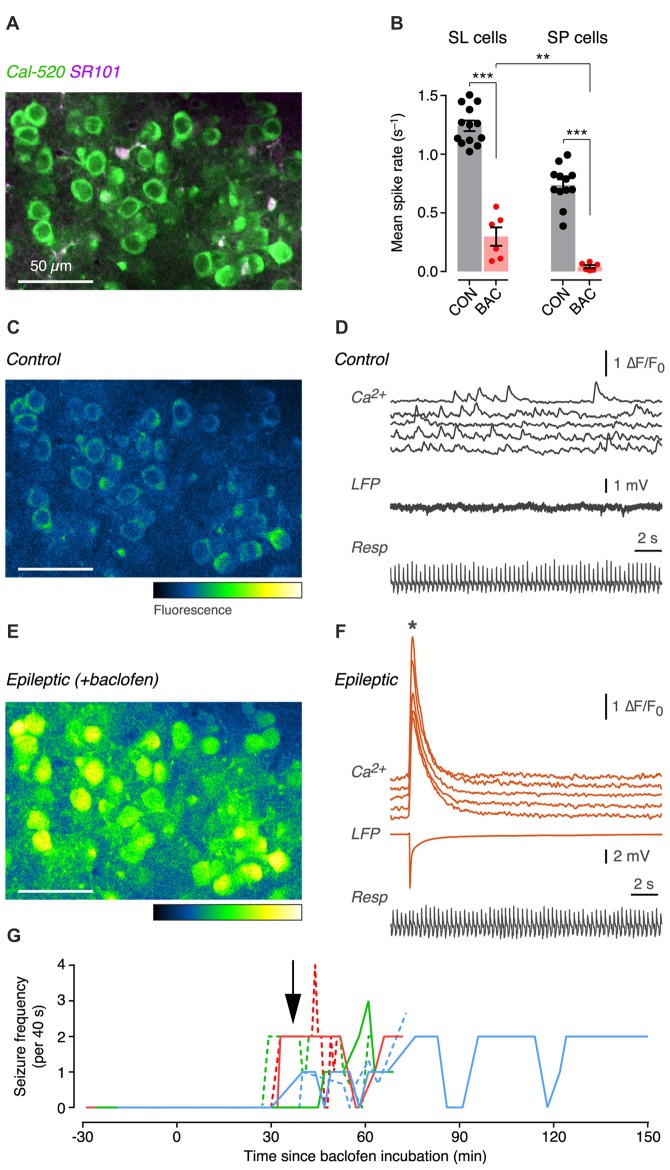
GABAB receptor activation both suppresses and enhances the excitability of SL and SP cells in the PC in vivo. (A) Two-photon composite image of SP cell somas labeled with the calcium indicator, Cal-520. Sulforhodamine (SR101) labels astrocytes. (B) Mean spontaneous spike rates during control (CON, black) and after superfusion of 500 μM baclofen (BAC, red), measured for SL cells (left) and SP cells (right). Each point is the averaged firing rate for all cells (n ~ 60–230 cells) in a field of view in a single experiment (SL: CON, n = 13 mice; BAC, n = 6; SP: CON, n = 12; BAC, n = 6). Shaded bars show the mean; error bars show ± SEM. (C) Example pseudocolor image of fluorescence intensity in the field shown in (A) under control conditions. Pseudocolor fluorescence scale shows low to high intensity. (D) Simultaneously recorded ∆F/F0 traces from five cells in the field in (C) showing spontaneous activity (top), the local field potential (LFP) recording (middle) and the respiration of the animal (bottom) under control conditions. (E) Same as in (C) but 36 min after baclofen was added to the superfusate. The image was taken at the time of the epileptic event indicated by the asterisk in (F). (F) Same as in (D), but after 36 min of baclofen. Note the large synchronous events seen in both the ∆F/F0 traces and the LFP trace. (G) Timecourse plot of the number of epileptic events observed in each 40 s-long movie of calcium fluorescence vs. the time since baclofen was first applied to the cortical surface. Each colored line shows the timecourse plot for each of n = 6 mice. Arrow indicates the mean latency to onset of the first seizure event, averaging across all mice. **p < 0.01; ***p < 0.001.